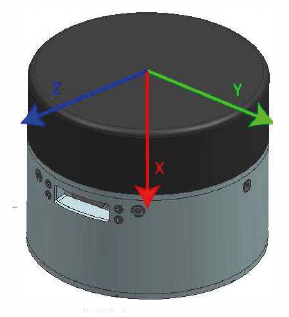
Figure 1: FFU with a body fixed coordinate